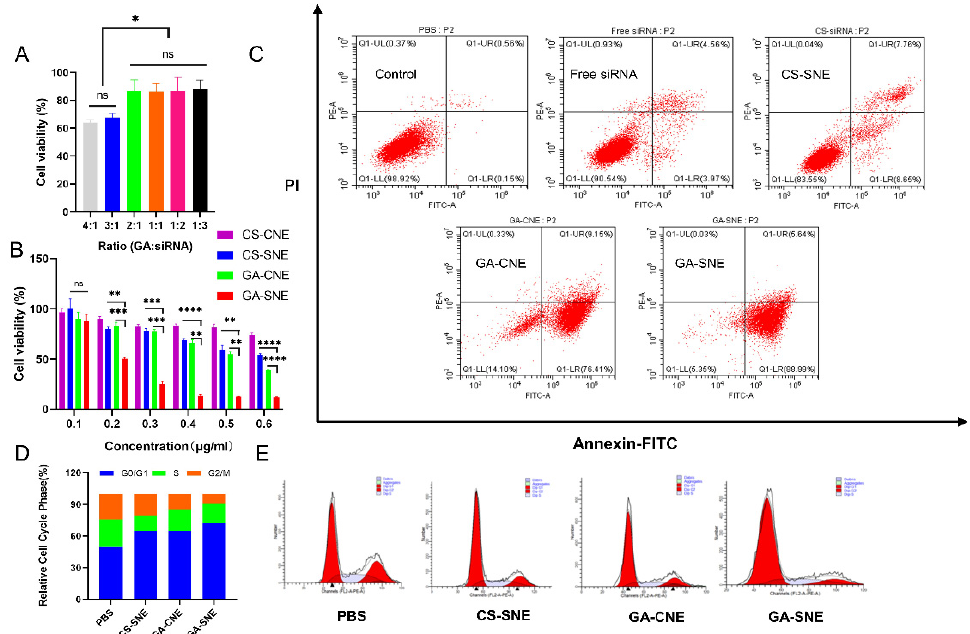
Figure 3. Effects of GA on cancer cells. ( A ) Cell viability of A549 cells after incubation with GA-SNE with different GA/siRNA ratios. ( B ) In vitro cell viability of A549 cells following incubation with CS-CNE, CS-SNE, GA-CNE, and GA-SNE nanoemulsions for 24 h, respectively. ( C ) A549 cells were treated with different formulations, and cell apoptosis was detected by flow cytometry. ( D ) Cell cycle quantification is treated with different preparations. ( E ) A549 cells were employed with different formulations for 24 h. The cell cycle was evaluated by flow cytometry (the value bars with ns are not significant, * p < 0.05, ** p < 0.01, *** p < 0.001, **** p < 0.0001).